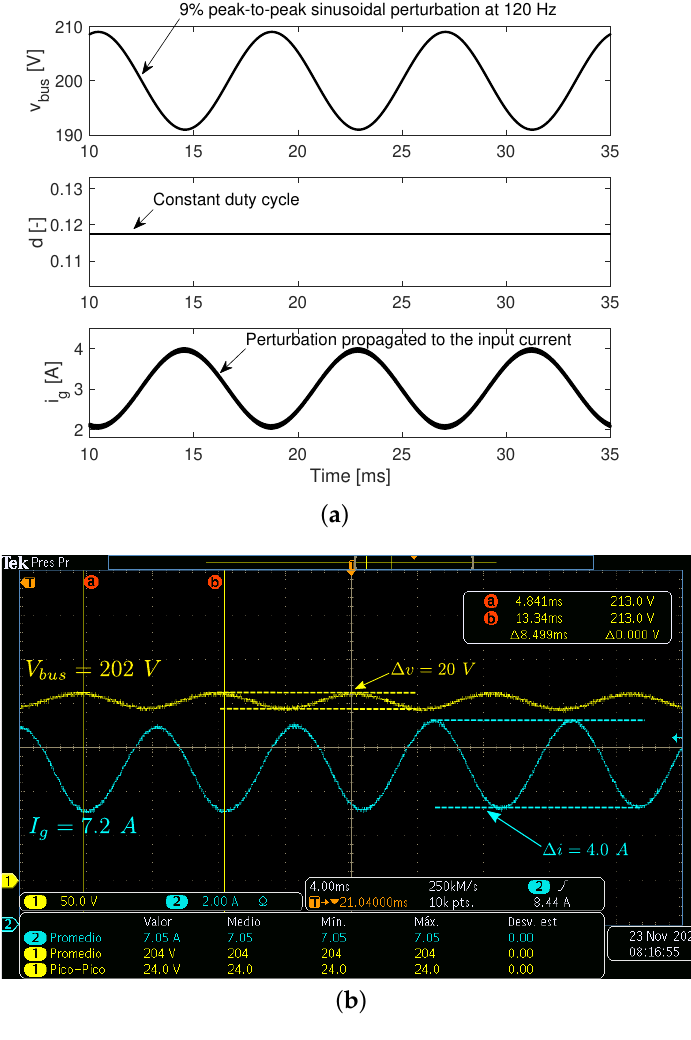
Figure 6. Behavior of the flyback with constant duty cycle. ( a ) Simulation of the first stage with the constant duty cycle. ( b ) Experimental behavior of the first stage with a constant duty